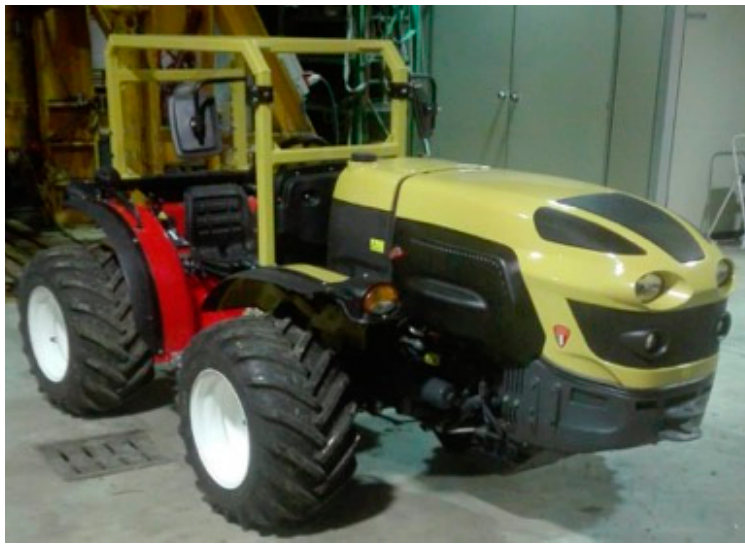
Figure 7. The built TRACLAS compact tractor.